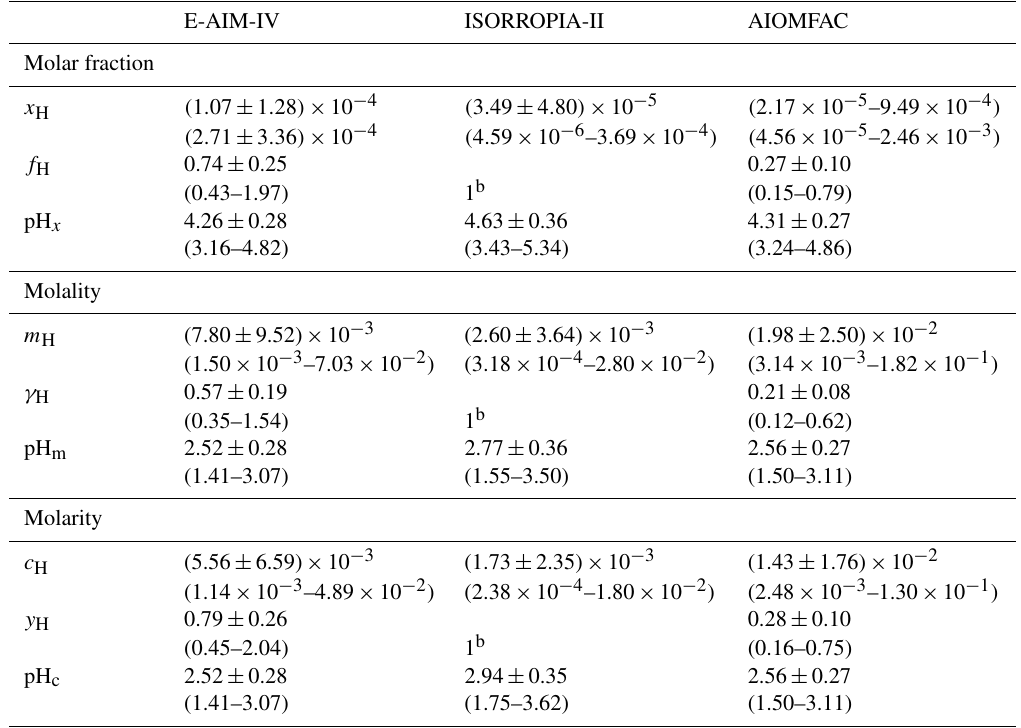
Table 2. Calculated concentrations, activity coefficient of H + and pH for the three thermodynamic models.